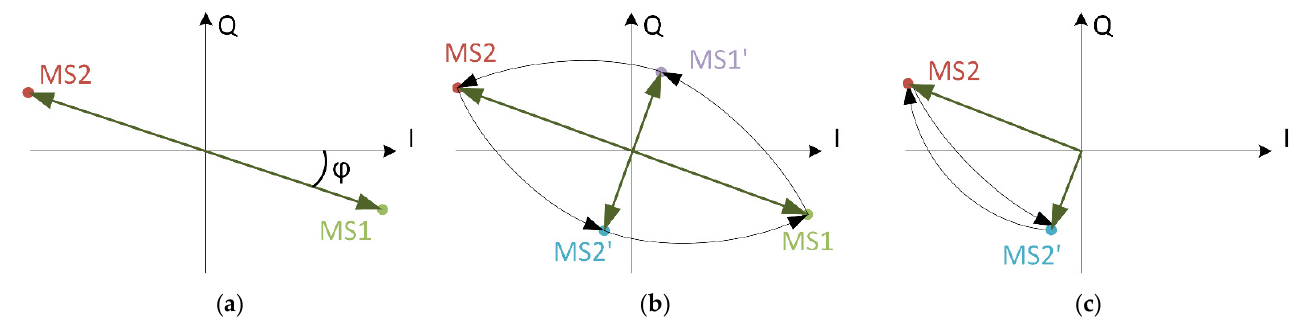
Figure 3. Subcarrier on the reader side is represented as modulated states (MS) for different transmissions. ( a ) Transmission, where the carrier phase is shifted for 180°—XOR mode. ( b ) Transmission with the orthogonal phase transition shaping (OPTS). ( c ) Special case of OPTS where MS2 is repeated as is the case of BPSK subcarrier modulation. MS1 and MS1’ are not shown in the diagram.